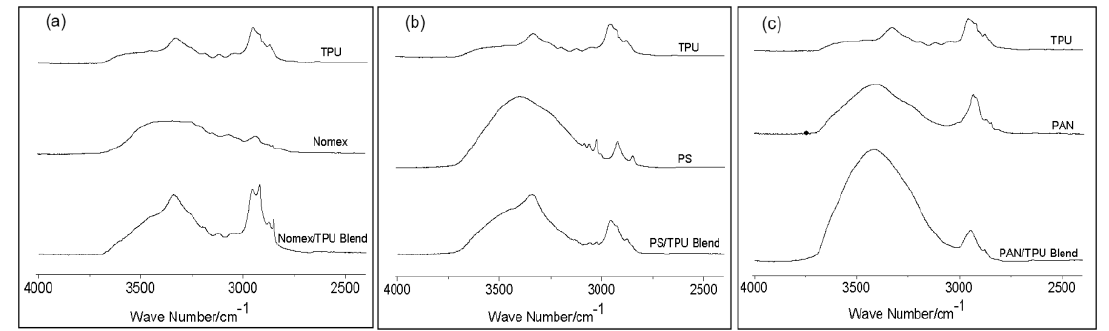
Figure 3. Fourier transform infrared spectroscopy (FTIR) of the three component systems including pure polymers and the blends: ( a ) Nomex/TPU, ( b ) PS/TPU, and ( c ) PAN/TPU.